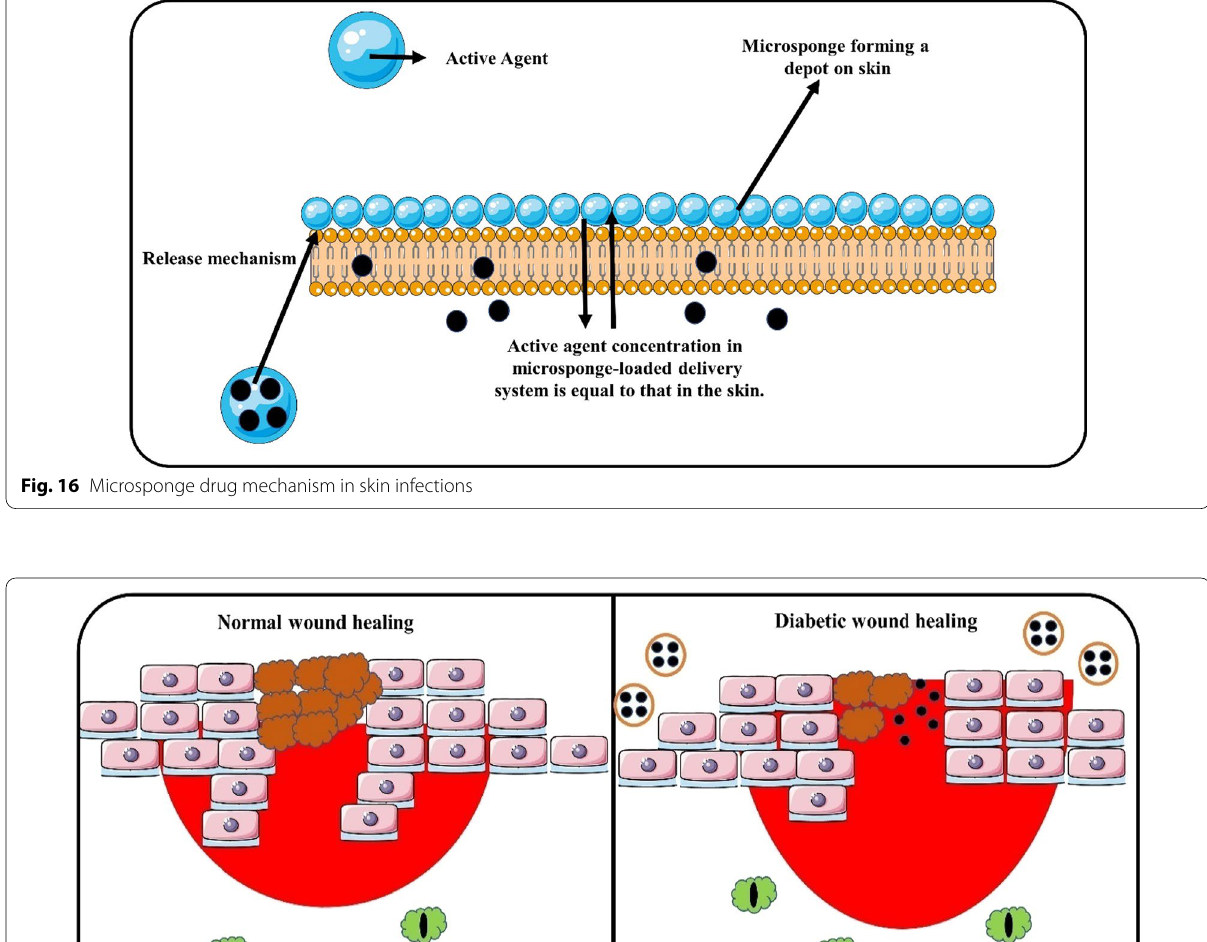
gel. The drug-loaded plain gel released 96.65 per cent of